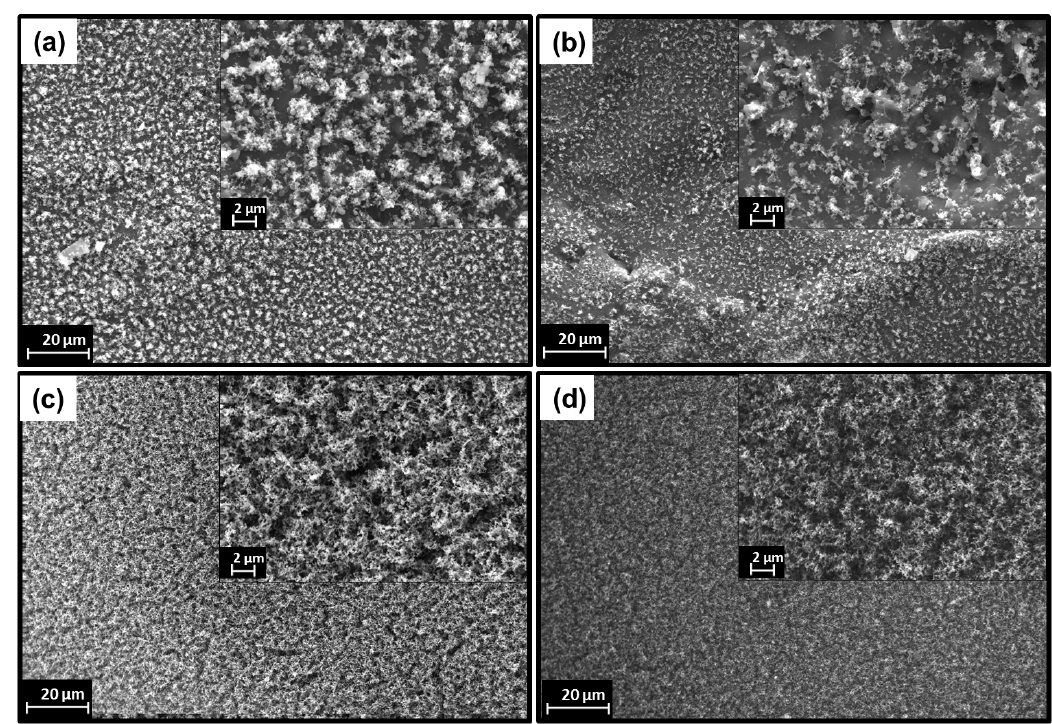
Figure 11. Scanning Electron Microscopy (SEM) micrographs of char residue surface after forced combustion for ( a ) PA 80 –LL 10 –AlP 10 ; ( b ) PA 80 –LL 10 –ZnP 10 ; ( c ) PA 80 –DL 10 –AlP 10 and ( d ) PA 80 –DL 10 –ZnP 10 blends at 1000× and 5000× magnification.